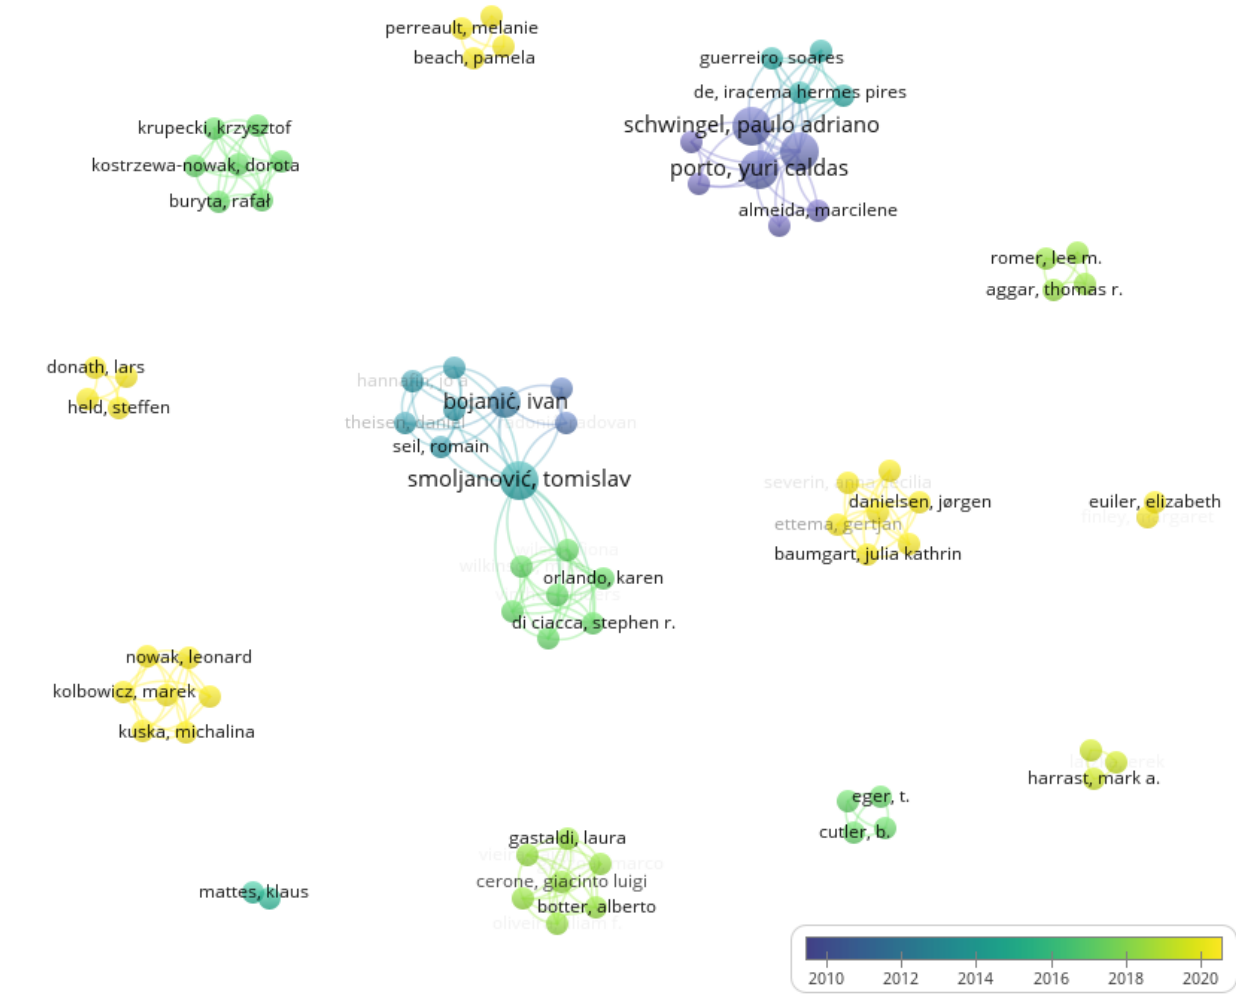
Figure 2. Bibliometric map showing connections of the authors in the fi eld of para-rowing. Table 5. The ten most productive authors on para-rowing.